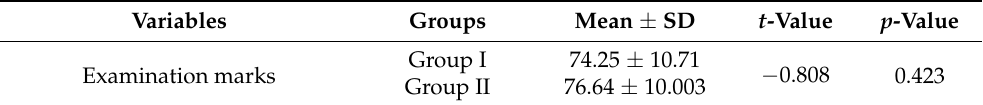
Table 1. Comparison of third-year examination marks between the two groups.